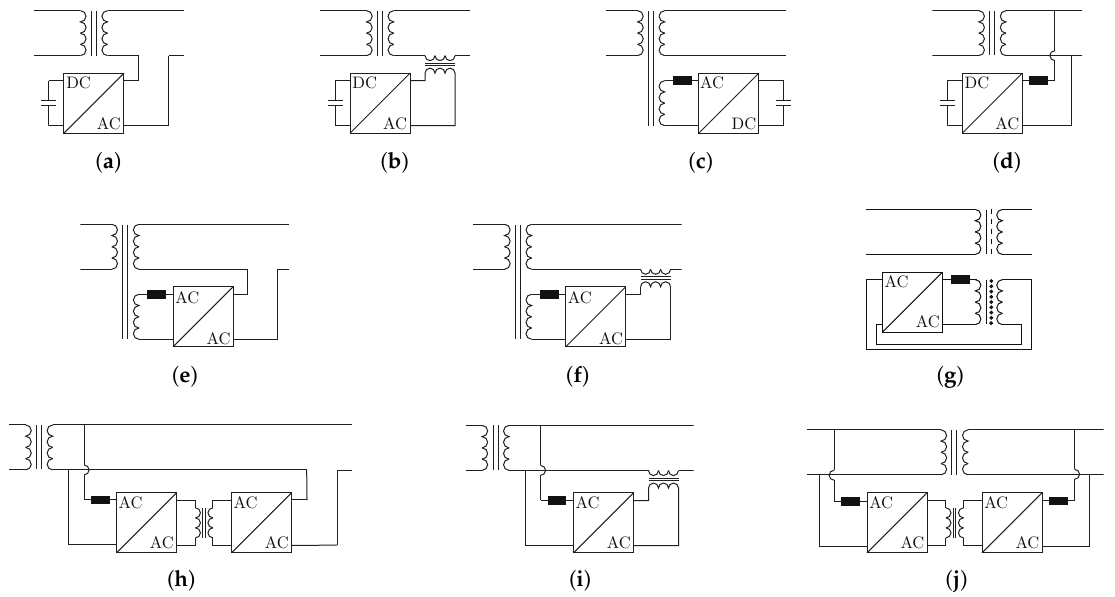
Figure 2. HDT configurations. ( a ) Power converter connected in series without a coupling transformer (CT). ( b ) Power converter connected in series with CT. ( c ) Power converter connected to the low-frequency transformer (LFT) core. ( d ) Power converter connected in shunt configuration. ( e ) Power converter connected to auxiliary windings (AWs) and in series without CT. ( f ) Power converter connected to AWs and in series with CT. ( g ) Power converter connected to two AWs. ( h ) Power converter connected to the secondary-side and in series without CT. ( i ) Power converter connected to the secondary-side and in series with CT. ( j ) Power converter connected to both sides of the LFT in shunt